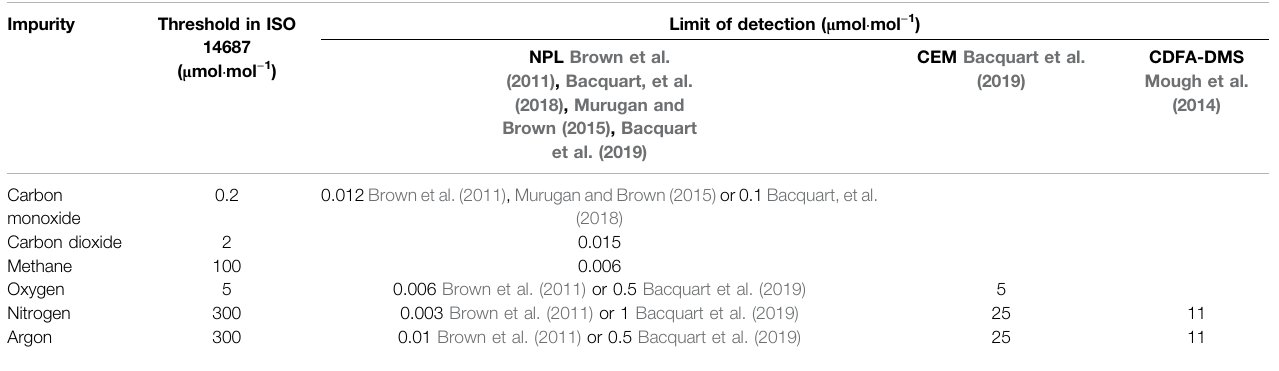
TABLE 3 | Detection limit per impurity with GC-PDHID for NPL, CEM and